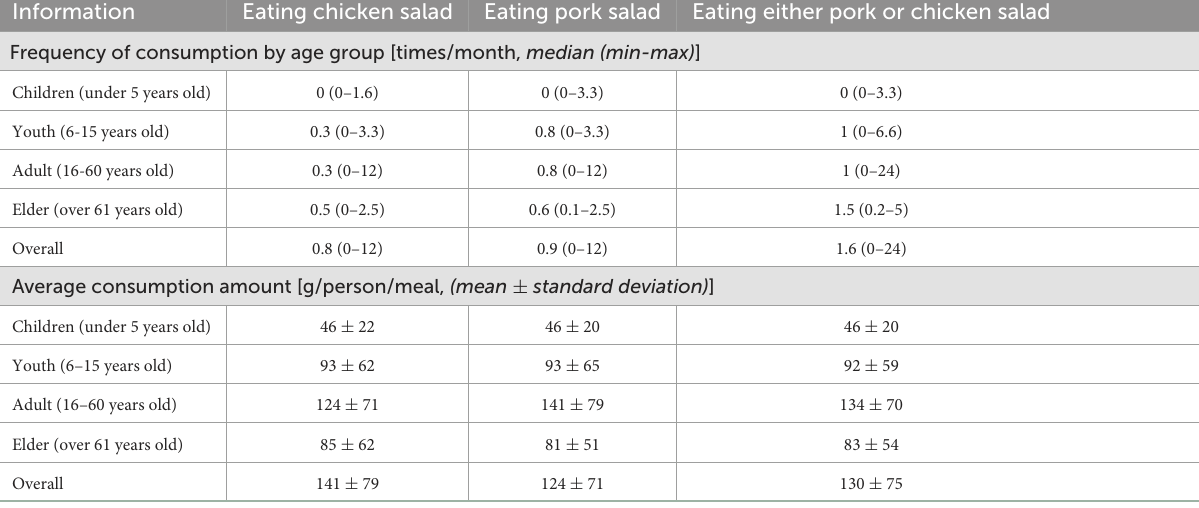
TABLE 3 Frequency and the average amount of chicken and pork salad consumption by age groups in Cambodian households.